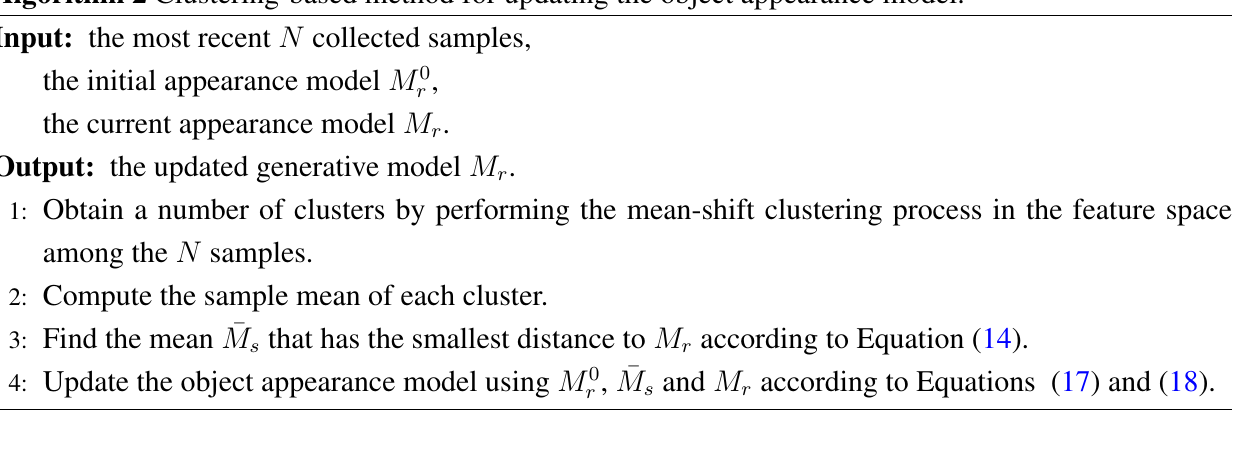
Algorithm 2 Clustering-based method for updating the object appearance